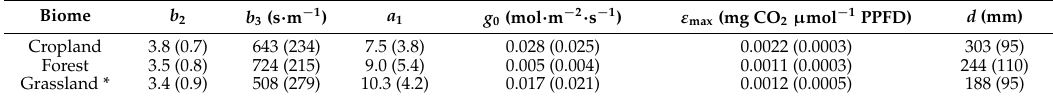
Table 1. Look-up table of model parameters for each biome type. The values in parentheses are standard